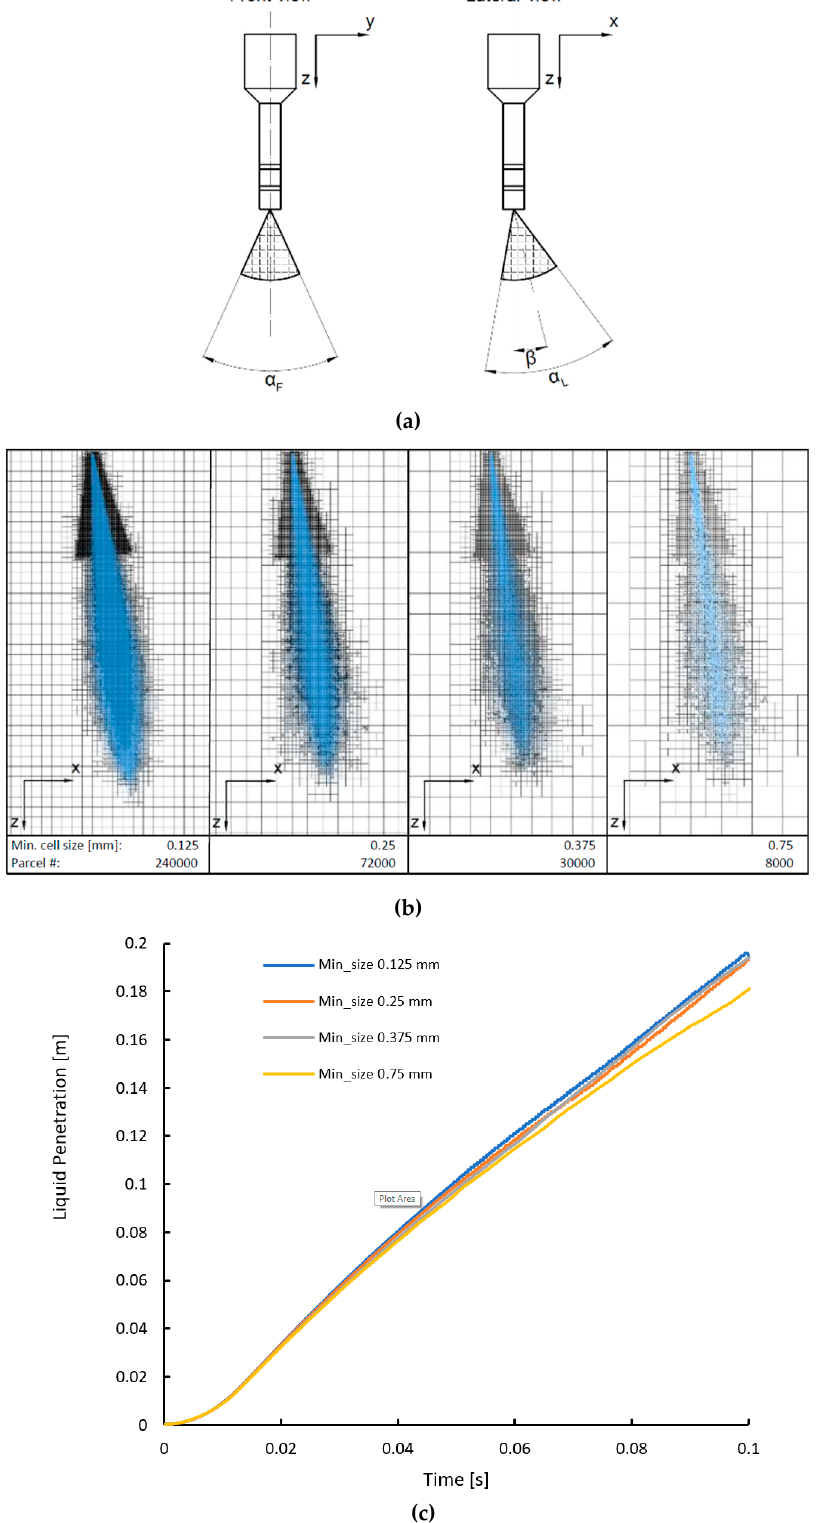
Figure 2. Spray angles definition ( a ), grid size effects on spray patterns ( b ) and on tip penetration ( c ) under conditions specified in Table 3.